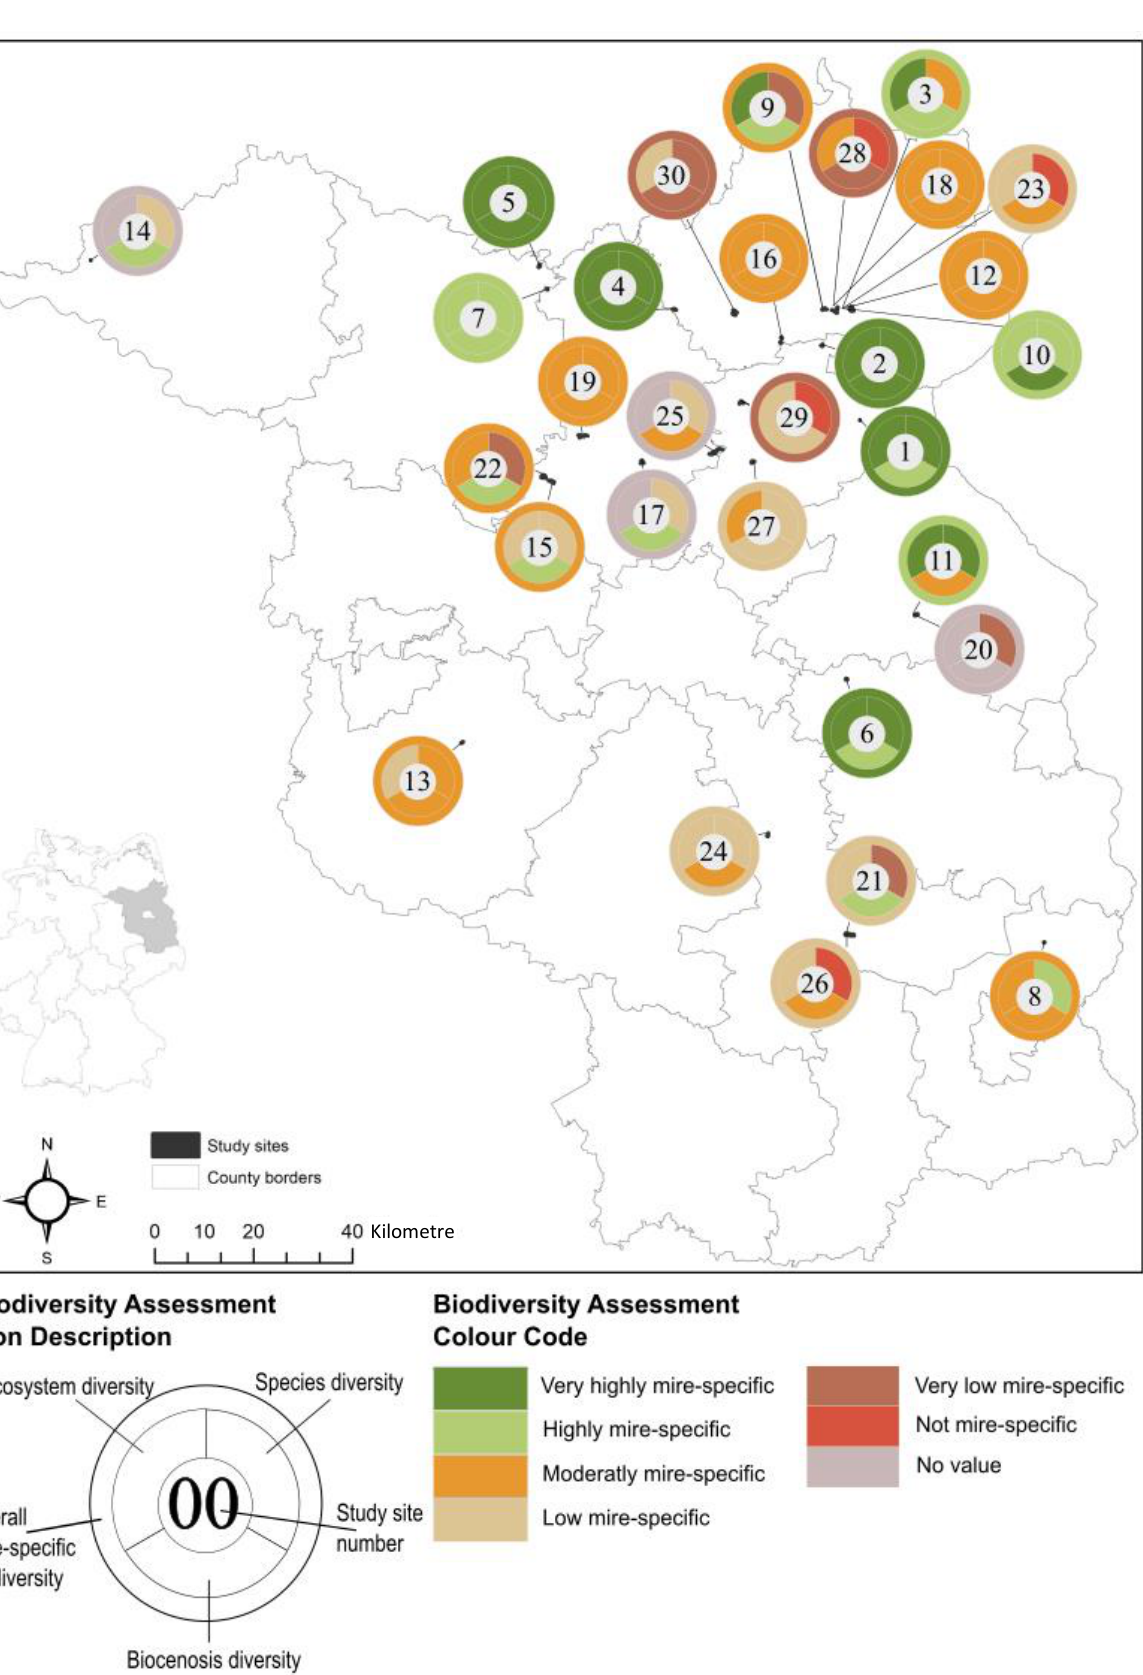
Figure 4. Visualisation of mire-specific biodiversity for the 30 sampled study sites in Brandenburg (north- east Germany (edited by J. Hammerich, source: County borders: VG250®ATKIS, ©BKG 2006).